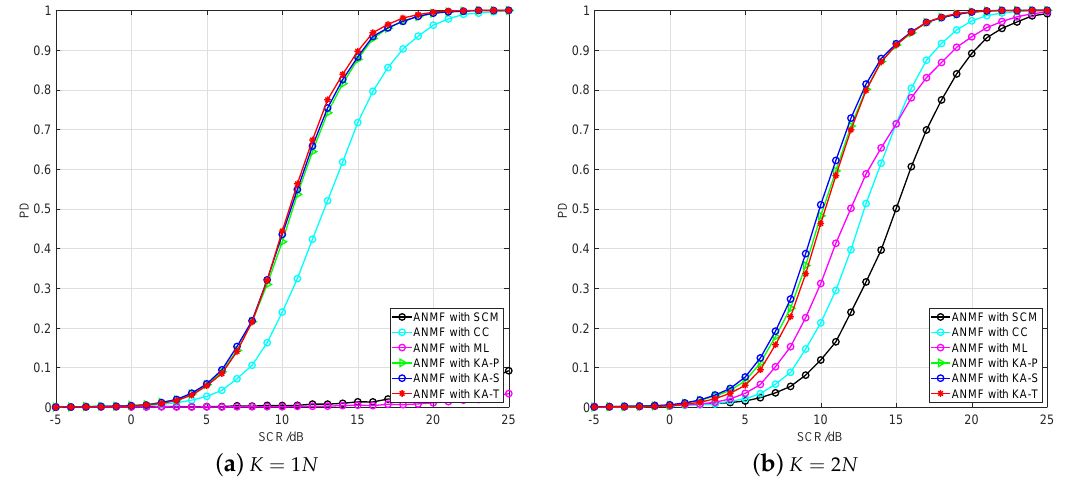
Figure 7. PD versa SCR for IPIX Radar data under different number of secondary